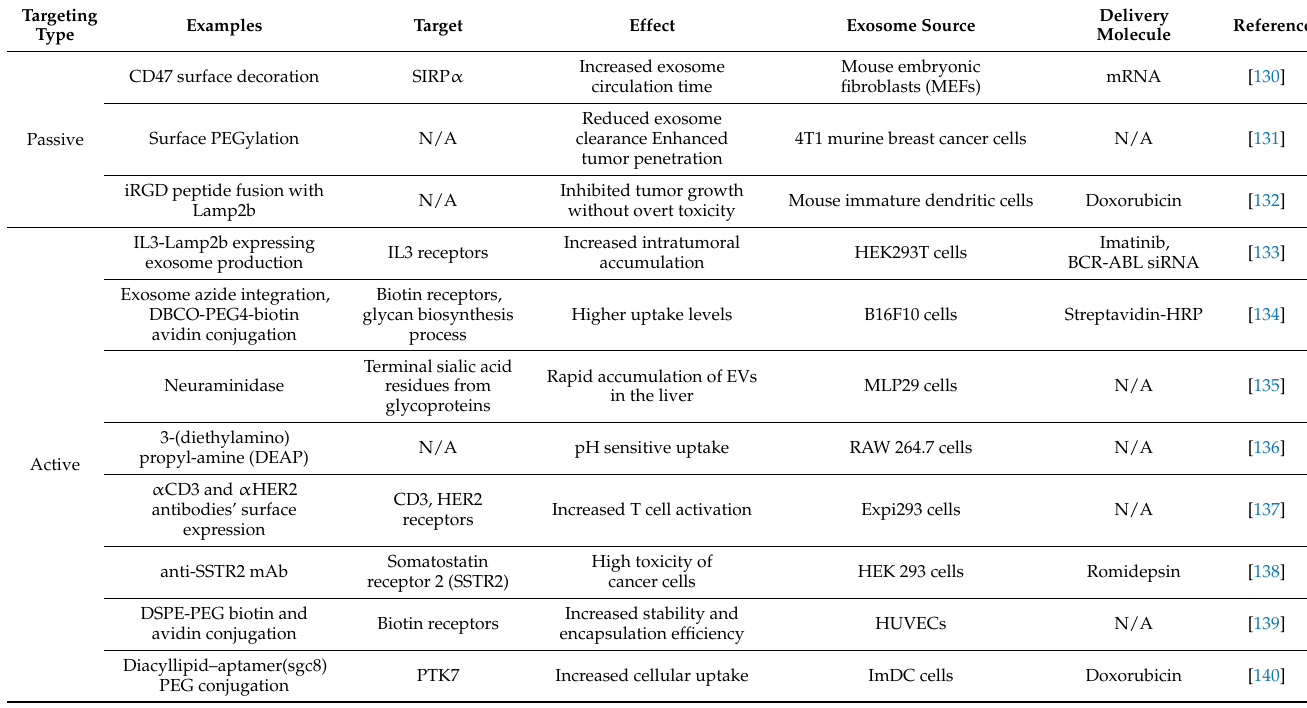
Table 3. Exosome modification strategies to improve exosome tumor targeting